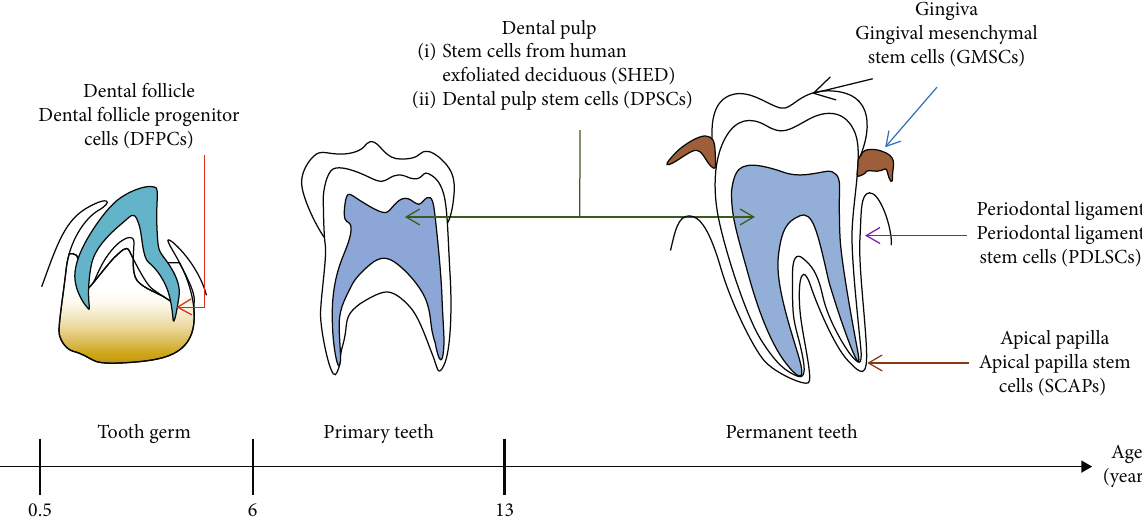
Figure 1: Tooth developmental stages with the anatomical localization of the di ff erence dental-derived stem cells in a tooth germ, primary teeth, and permanent teeth. Di ff erent subpopulations of DSCs can be categorized according to their tissue of origin. Modi fi ed from